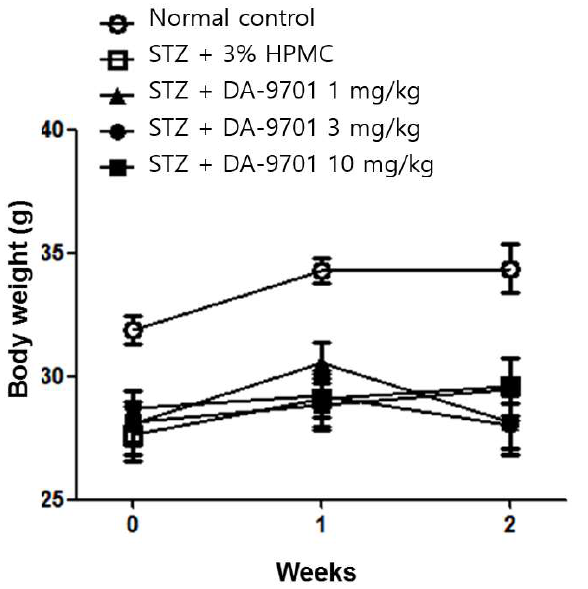
Figure 4. Effect of DA-9701 on body weight in normal control and streptozotocin-induced diabetic mice . STZ-induced diabetic mice had significantly lower body weight compared to control. DA- 9701 had no effect on the body weight of the streptozotocin-induced diabetic mice. (n = 10 in each group).